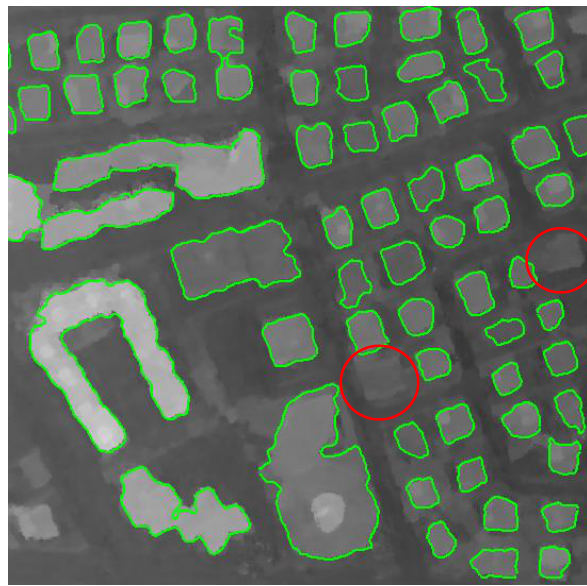
Figure 4. Results of RG_AC upon the DSM. The green boundaries are the output of level 1 in building extraction method and red regions are non-detected buildings.